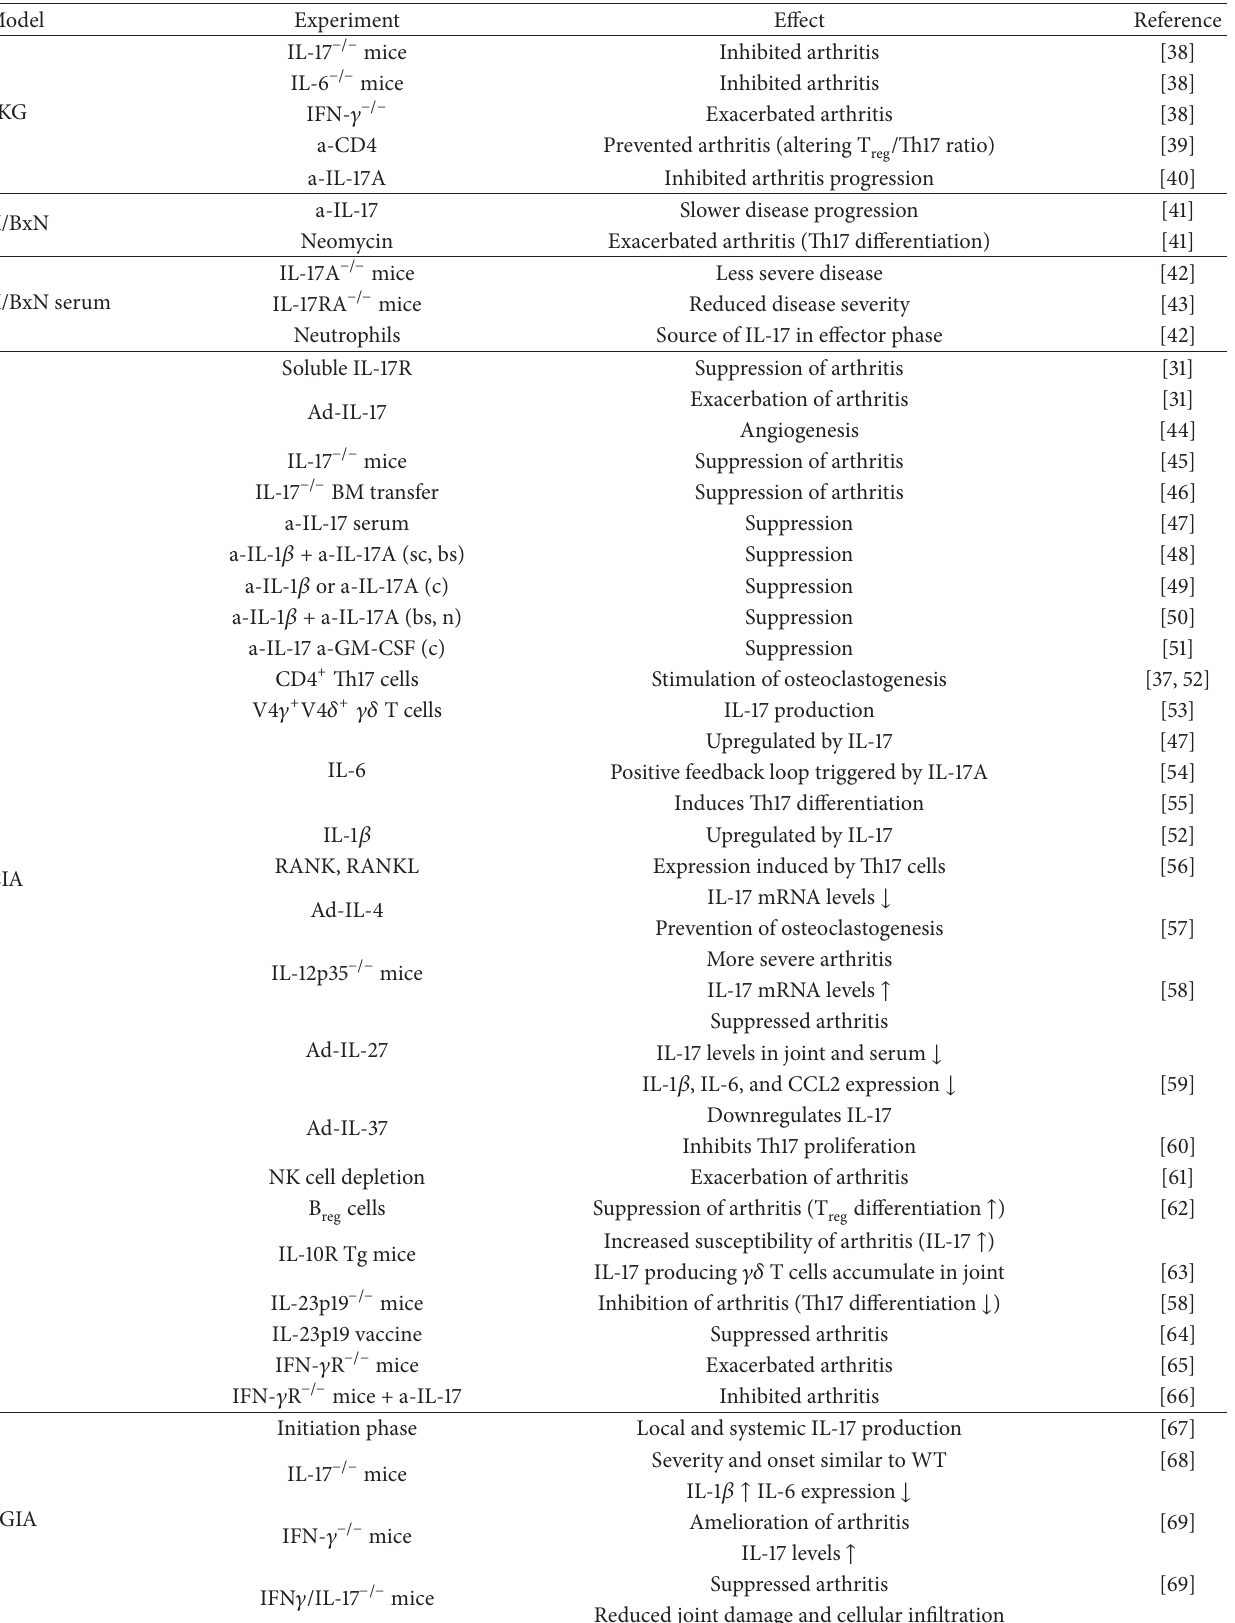
Table 1: Summary of the most important data about IL-17 in animal models of